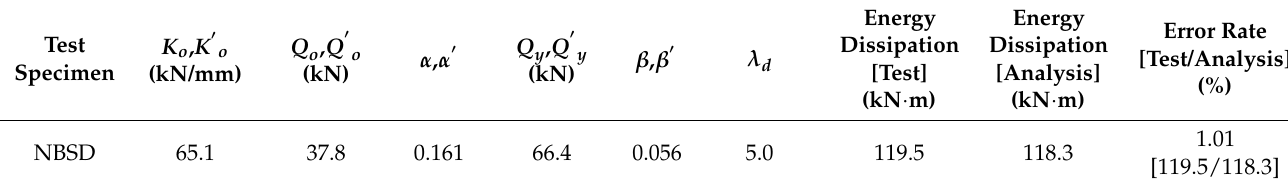
Table 11. Parameters used in the modified Ramberg-Osgood (MRO) model for the NBSD system.